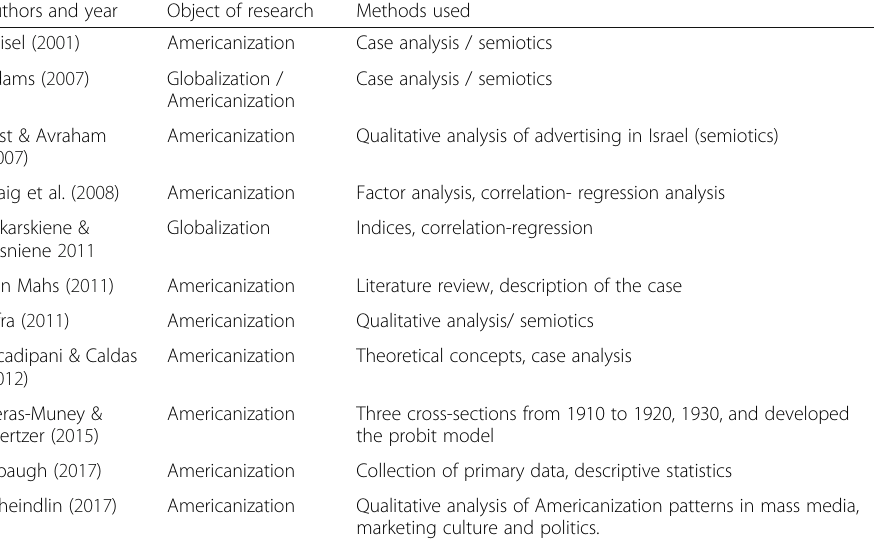
Table 2 Summary of studies on Americanization and globalization (Source: compiled by the authors) Authors and